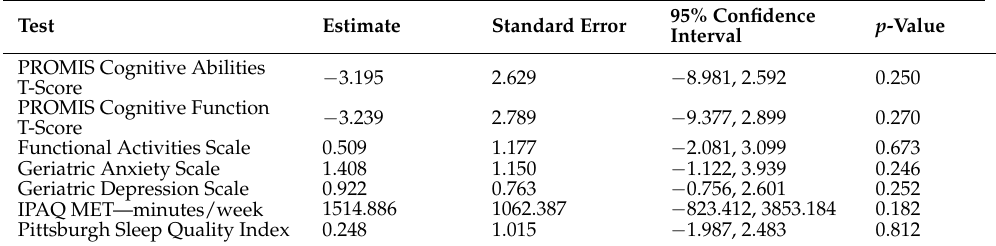
Table 5. Overall scores for self-report instruments—change from baseline estimates.